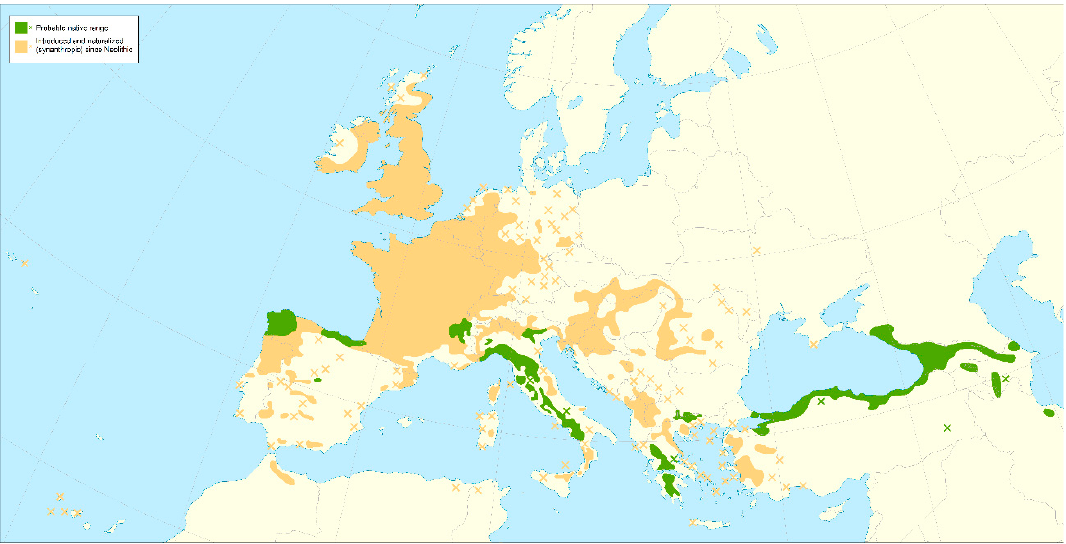
Figure 4. Castanea sativa Mill. distribution map [62]. https://commons.wikimedia.org/wiki/File:Castanea_sativa_range.svg